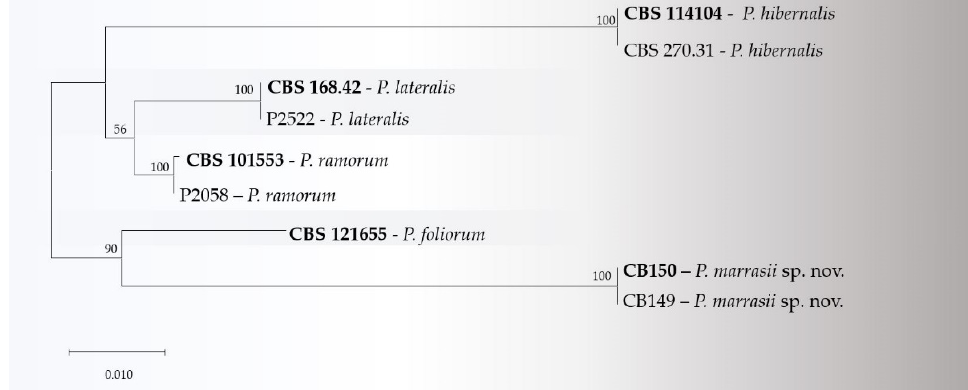
Figure 3. Maximum likelihood tree obtained from concatenated ITS and Btub sequences of Phytophthora species belonging to clade 8c. Data are based on the general time reversible model. A discrete Gamma distribution was used to model evolutionary rate differences among sites. The tree is drawn to scale, with branch lengths measured in the number of substitutions per site. Bootstrap support values in percentages are given at the nodes. Ex-type cultures are in bold.